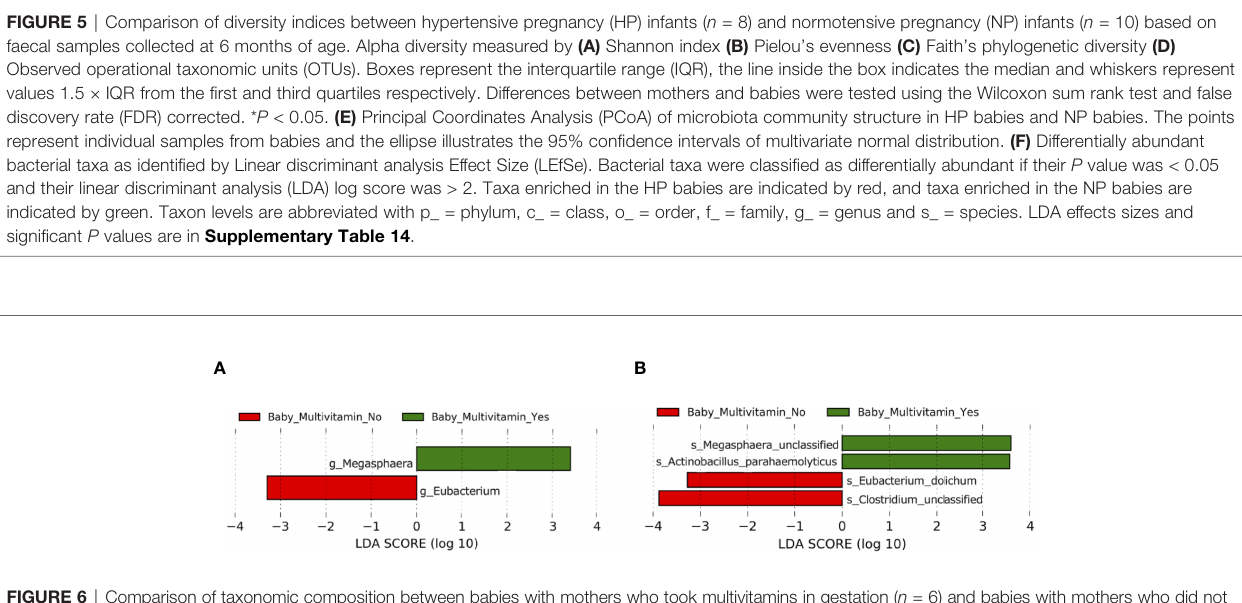
FIGURE 6 | Comparison of taxonomic composition between babies with mothers who took multivitamins in gestation ( n = 6) and babies with mothers who did not take multivitamins in gestation ( n = 12). (A) Differentially abundant bacterial genera as identi fi ed by Linear discriminant analysis Effect Size (LEfSe). (B) Differentially abundant bacterial species as identi fi ed by LEfSe. Bacterial taxa were classi fi ed as differentially abundant if their P value was < 0.05 and their linear discriminant analysis (LDA) log score was > 2. Taxa enriched in babies whose mothers did not take multivitamins in gestation are indicated by red, and taxa enriched in babies whose mothers did take multivitamins in gestation are indicated by green. Taxon levels are abbreviated with p_ = phylum, c_ = class, o_ = order, f_ = family, g_ = genus and s_ = species. LDA effects sizes and signi fi cant P values are in Supplementary Tables 21 – 22 .